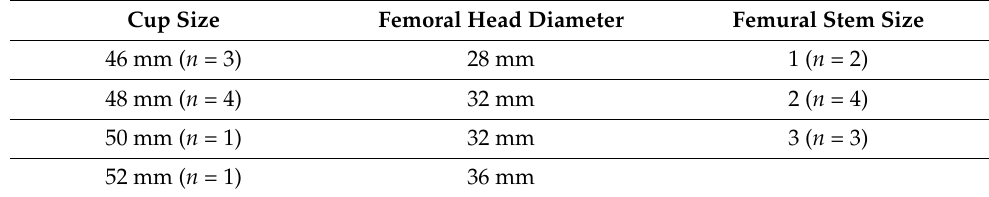
Table 2. Summary of implant